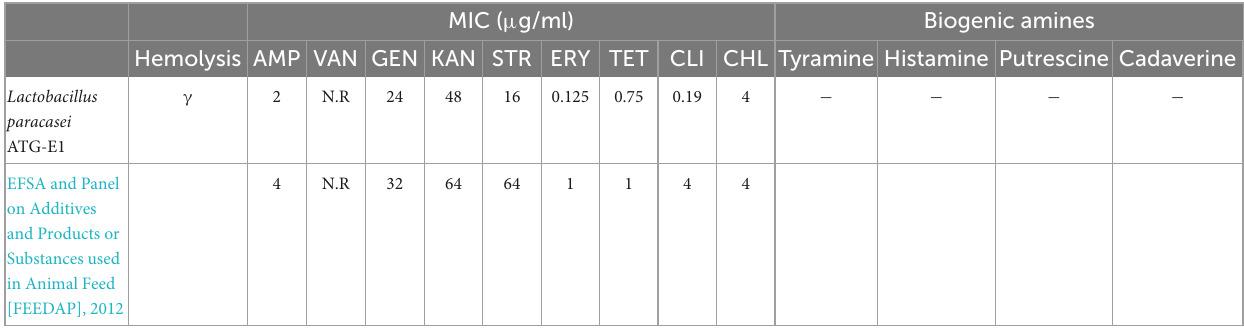
TABLE 2 In vitro safety test of L. paracasei ATG-E1. MIC ( µ g/ml) Biogenic amines